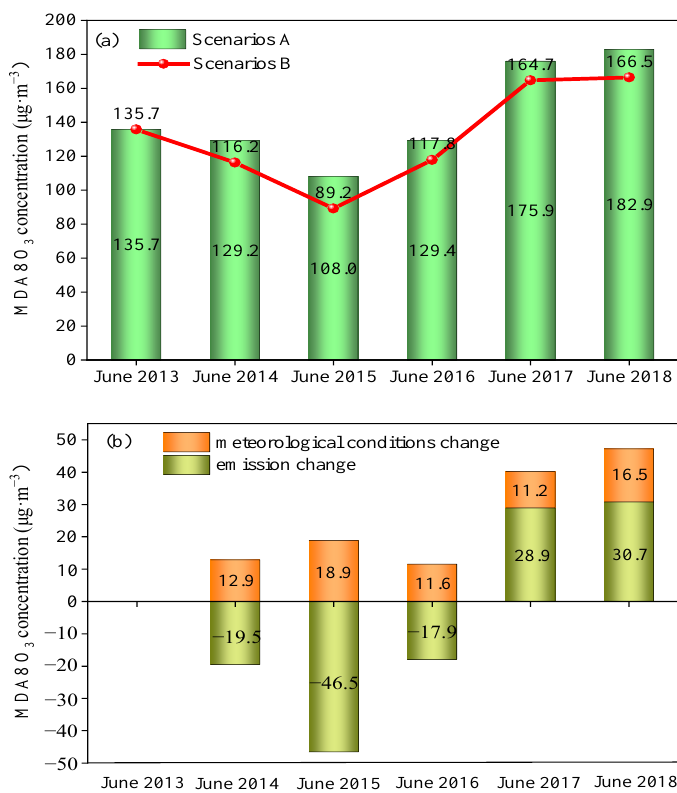
Figure 7. ( a ) Trend of the variation in O 3 under different simulation scenarios in downtown Handan from 2013 to 2018; ( b ) The impact of meteorology and emissions on the evolution of O 3 pollution in downtown Handan from 2013 to 2018.